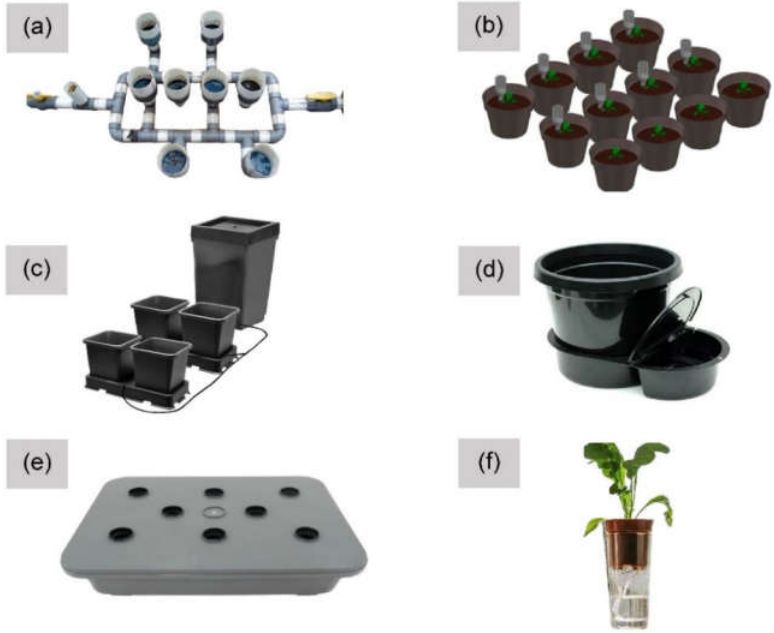
Figure 1. Various hydroponic kits worked without electrical energy suitable for remote areas, ( a ) closed-type irrigation system [10], ( b ) pocket fertigation [11], ( c ) Autopot ® [12], ( d ) Autopot ® Hydrotrays [12], ( e ) Kratky method [13], and ( f ) wick system [14].